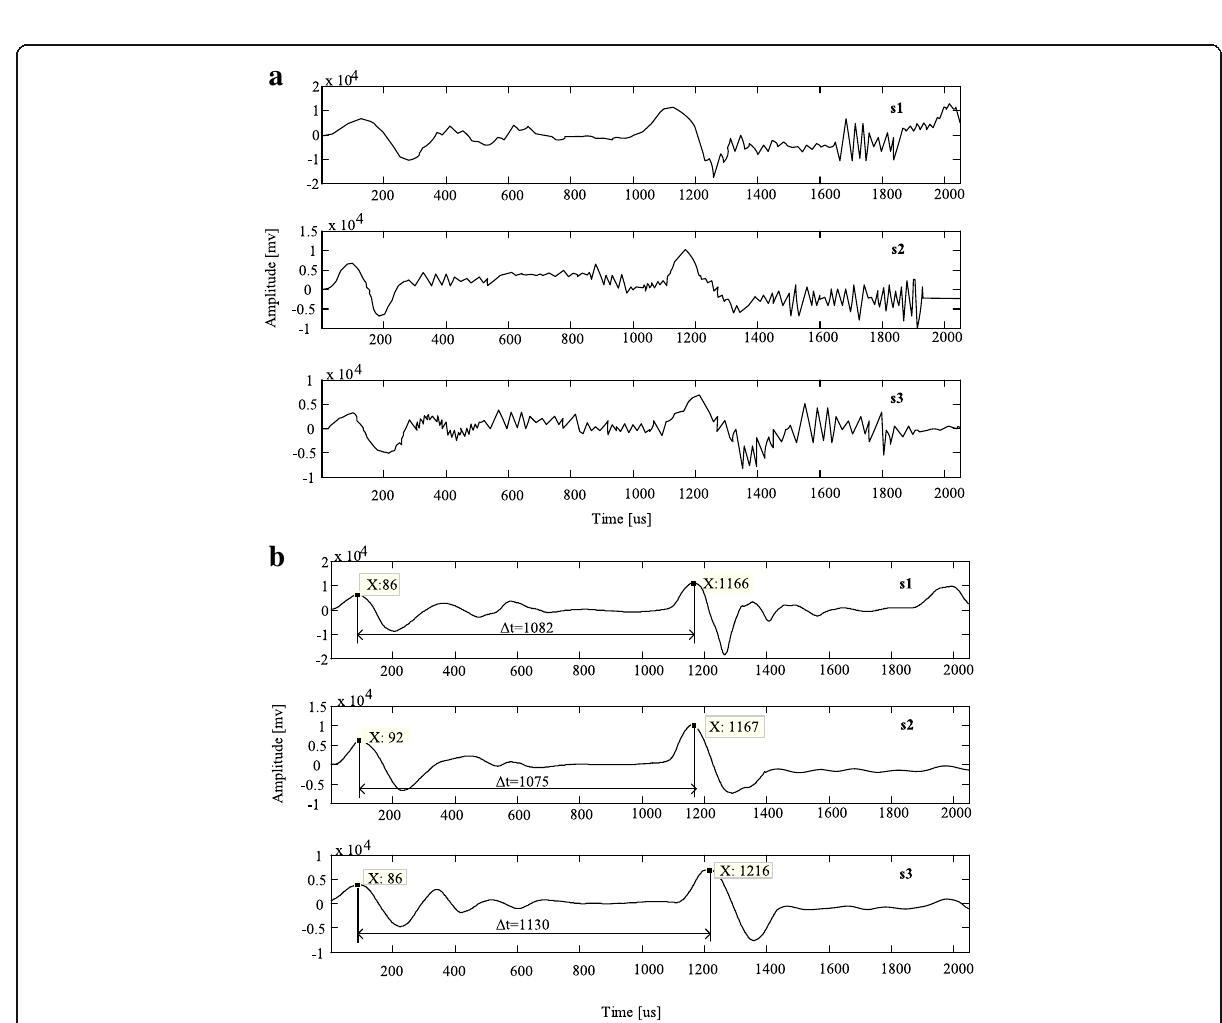
Fig. 6 The sociogram of the hollow grouted rock bolt exposed in the air after grouting ( a ). The original signal of s 1 , s 2 , and s 3 ( b ) low-frequency decomposition by 5 scale of s